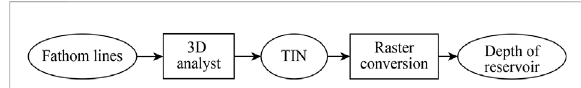
FIGURE 7 Processing of the reservoir